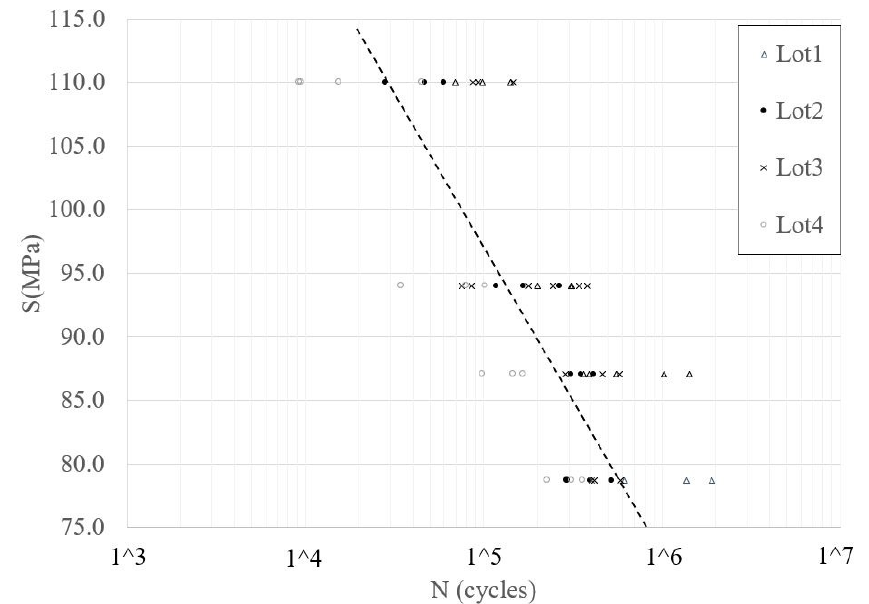
Figure 5. Uniaxial fatigue test